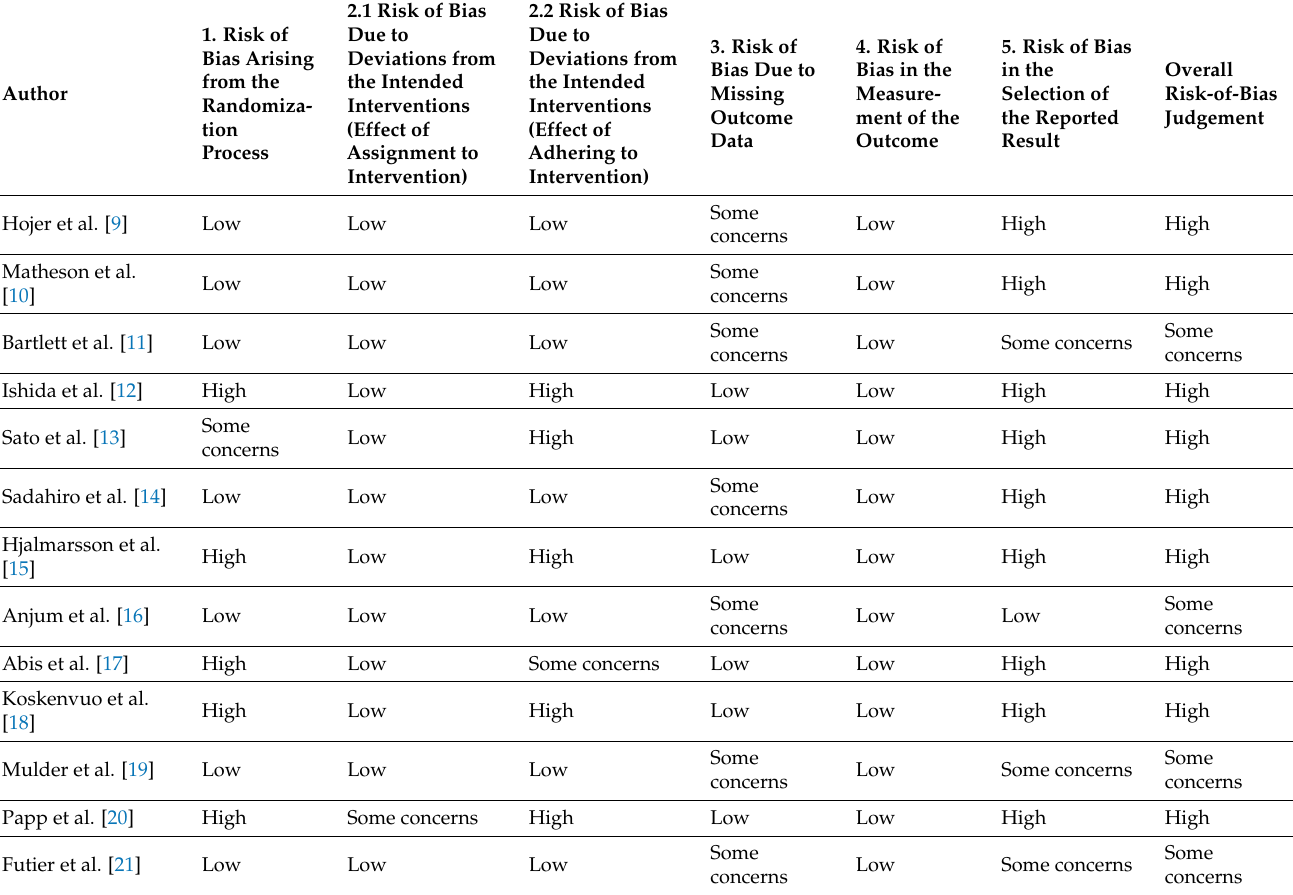
Table 1. Version 2 of the Cochrane risk-of-bias tool for randomized trials to assess the risk of bias in the findings of each study. The tool is structured into five domains. Trials are judged for each domain